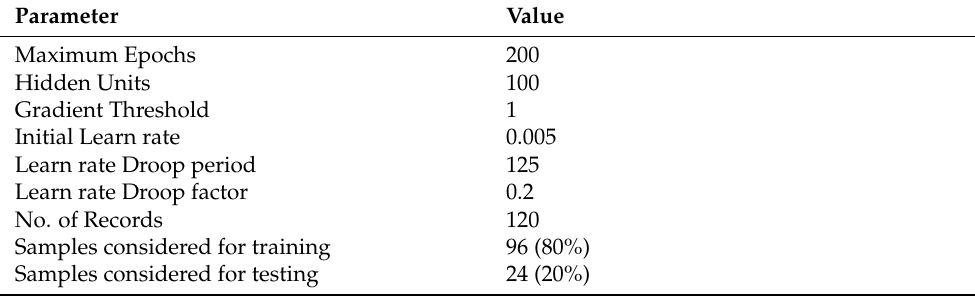
Table A1. Parameters considered for time series long short term memory (LSTM) Forecasting